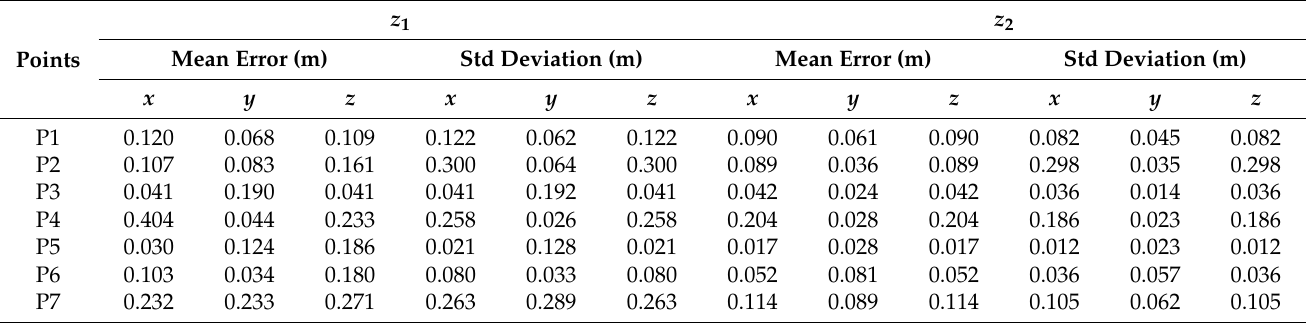
Table 3. Mean positioning errors and standard deviations for points P1–P7 at z 1 = 1.35 m and z 2 = 1.93 m after the LKF fusion.